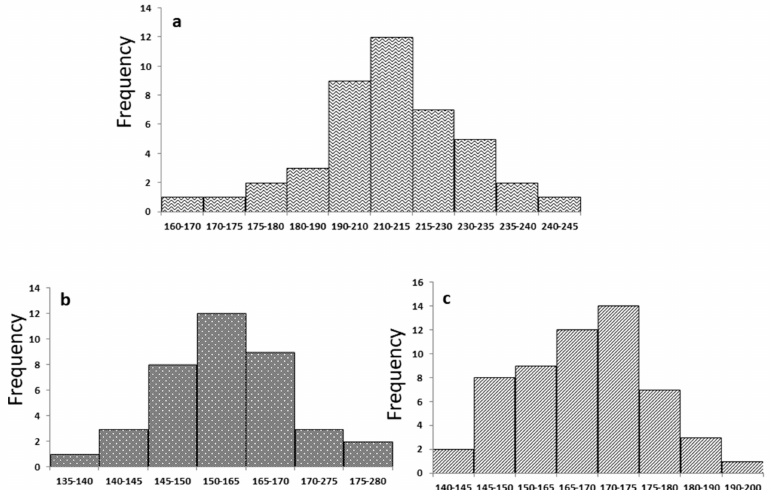
Figure 2. Frequency range of fiber diameters for ( a ) PCL, ( b ) PCL / SF, ( c ) PCL / SF / Au(SiO 2 ) nanofibrous sca ff olds.